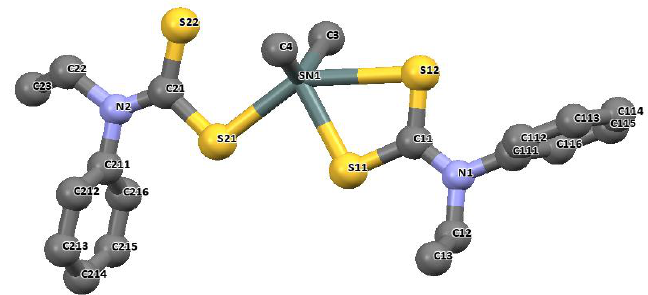
Figure 12. The molecular structure of dimethyltin(IV) complexes of N -ethyl- N -phenyl dithiocarbamate [Me 2 SnL 2 ]. (For clarity, H atoms were omitted). Redrawn from [89], with permission from Elsevier (Copyright 2018).